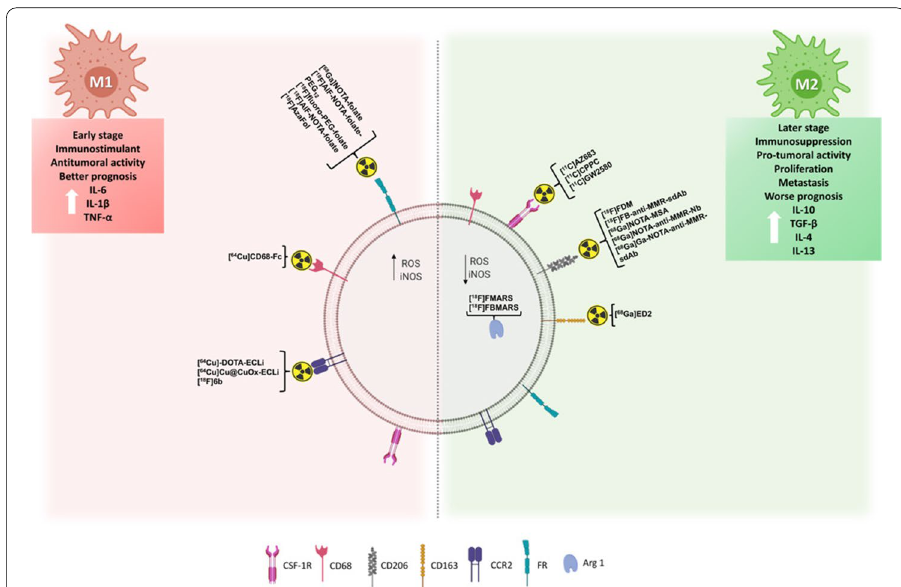
Fig. 1 The main biomarkers expressed by TAM phenotypes, for which PET tracers are available. For each biomarker, the available PET tracers are indicated. CSF-1R: colony stimulating factor 1 receptor; CD: cluster of differentiation; CCR2: C–C chemokine receptor type 2; FR: folate receptor; Arg1: arginase 1; IL: interleukin; TNF-α: tumoral necrose factor α; TGF-β: transforming growth factor